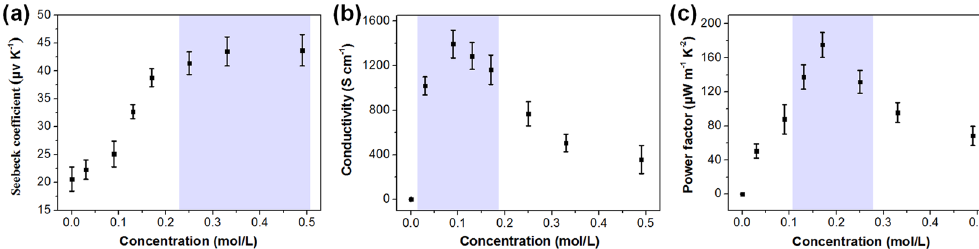
Fig. 7 TE property of PEDOT:PSS/IL hybrid. TE property of PEDOT:PSS hybrid fi lm as a function of the EMIM:TCM content ( a ) Seebeck coef fi cient, ( b ) electrical conductivity and ( c ) power factor. Error bars represent standard deviation with at least fi ve times measurement and it should be noted that some error bars are smaller than the plotting